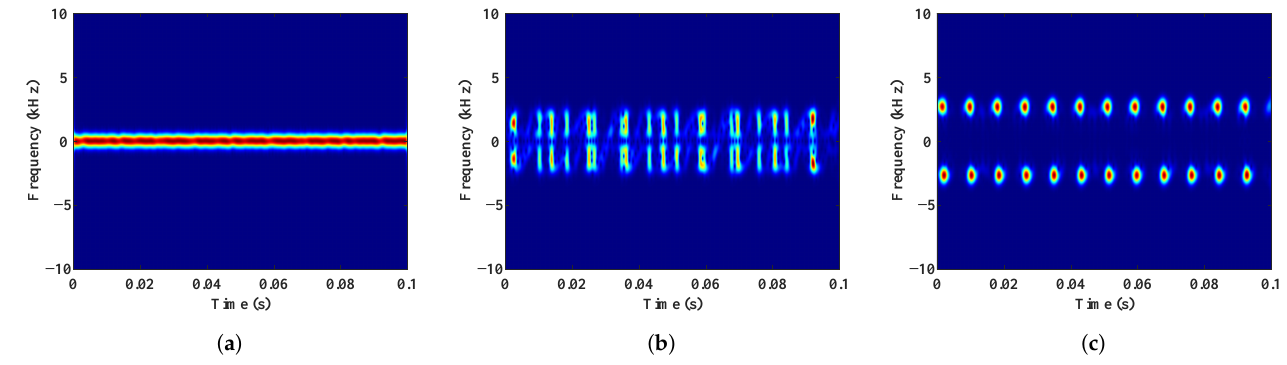
Figure 10. The three components obtained by CVMD. ( a ) Body component. ( b ) Intermediate fre- quency component. ( c ) High-frequency